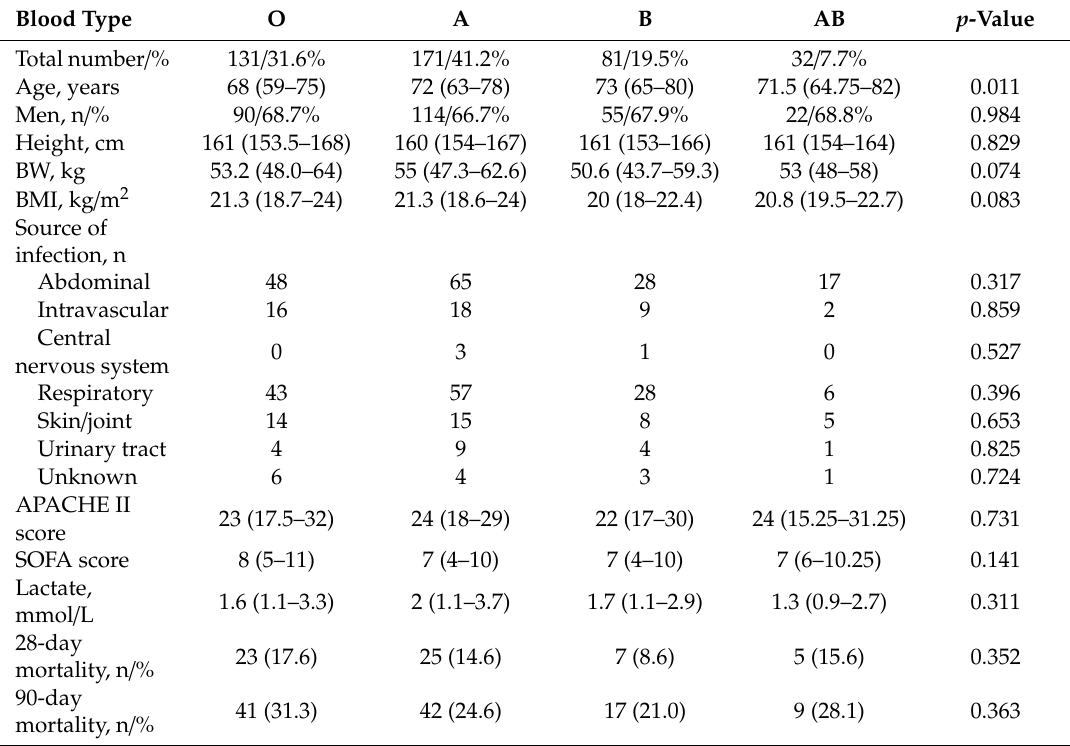
Table 1. Baseline characteristics and outcomes according to blood type in the study cohort. Blood Type O A B AB p